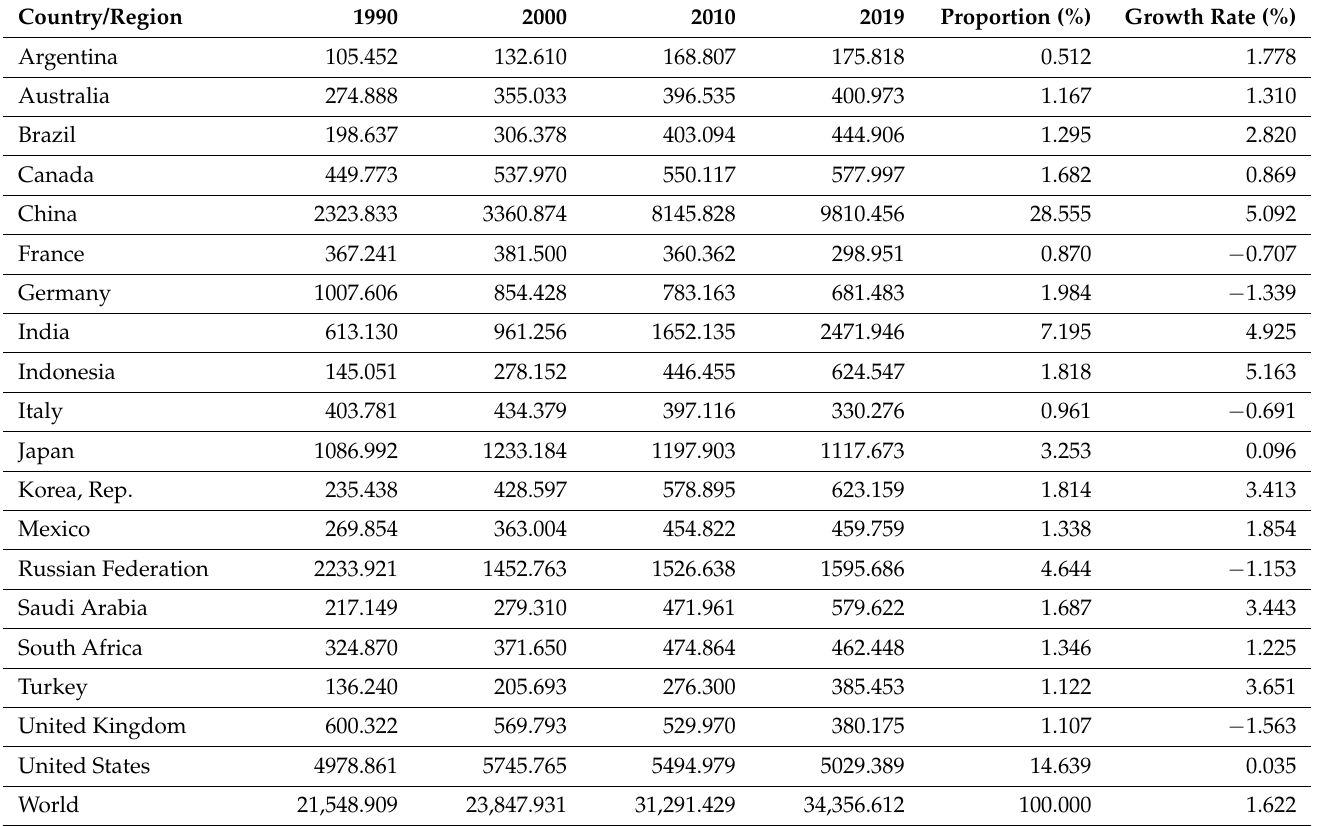
Table 2. Changes of CO 2 emission during 1990–2019